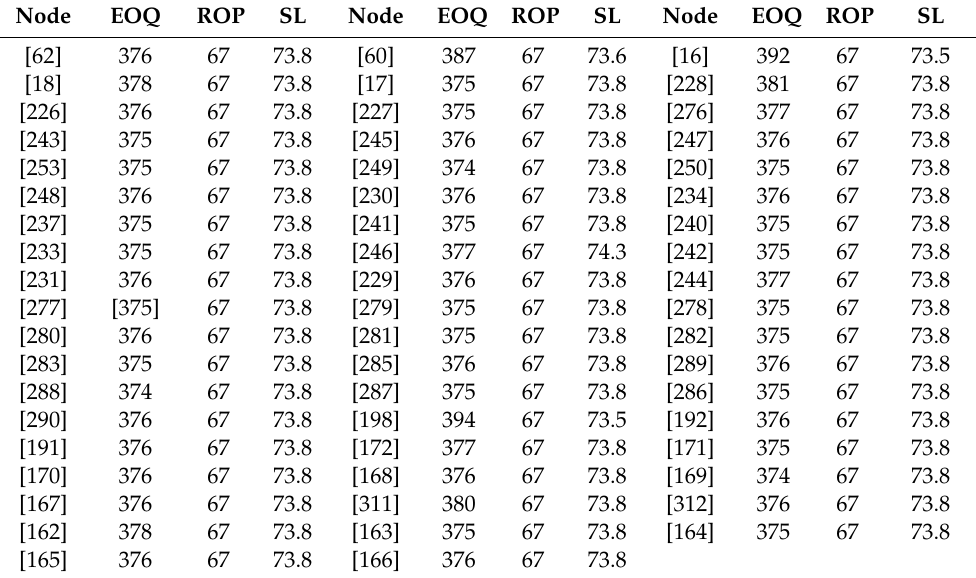
Table 4. The economic order quantities (EOQ), optimal reorder points (ROP), and optimal service levels (SL) of all retail stores located in Route 1 based on POPIRPSDR.